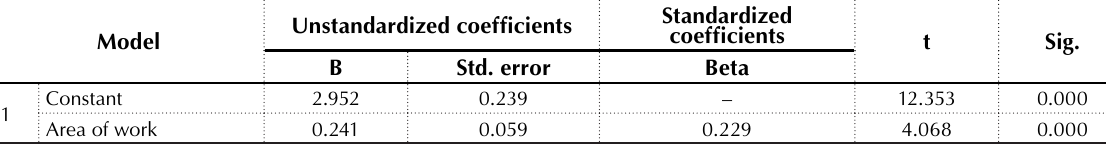
Table 4. Impact of area of work on acclimatization of